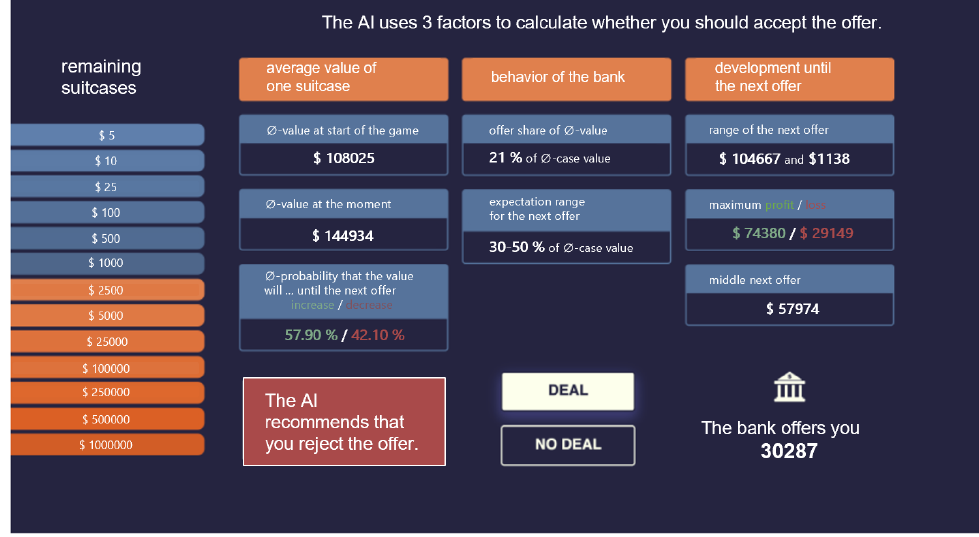
Figure 3. Example of a display in the ’complex’ explanation condition. The simple explanation also contained the three main sections, but contained only three subsections (quality of the offer compared to possible offers, probability that the next offer is better, comparison between a possible gain or loss on the next offer; Figure 4).